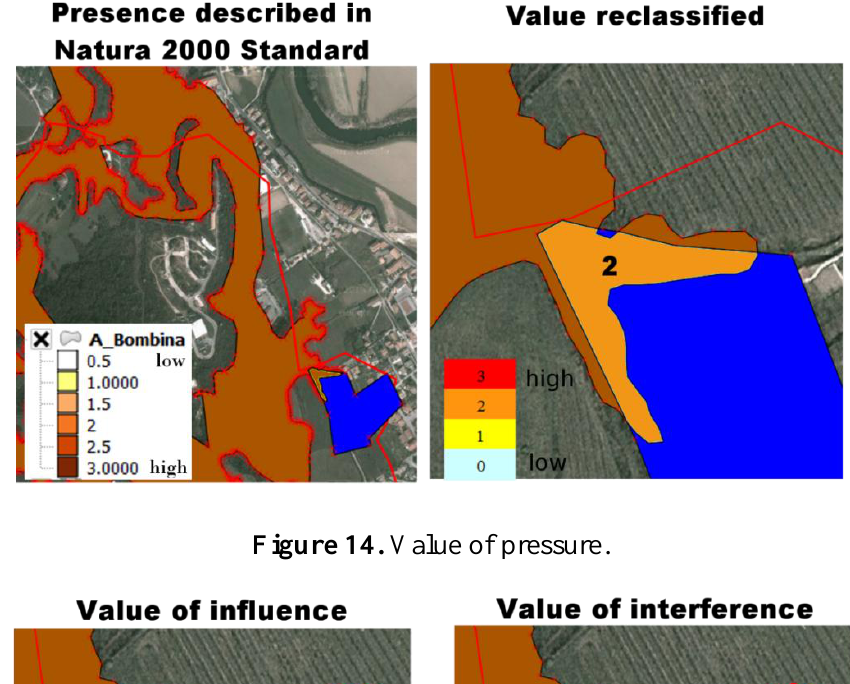
Figure 13. The value of interference calculated from the spatial overlap of areas.